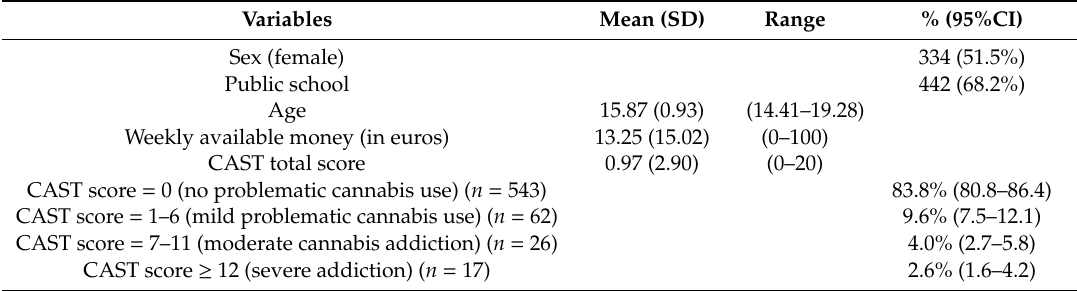
Table 1. Means (standard deviations) and frequencies of the main study variables ( n =